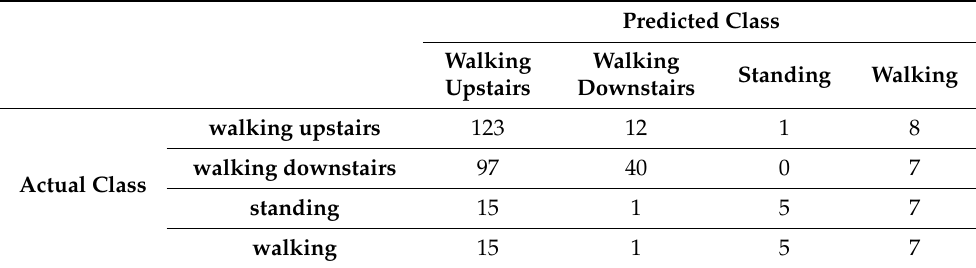
Table 6. Confusion matrix for normalized gyroscope data with